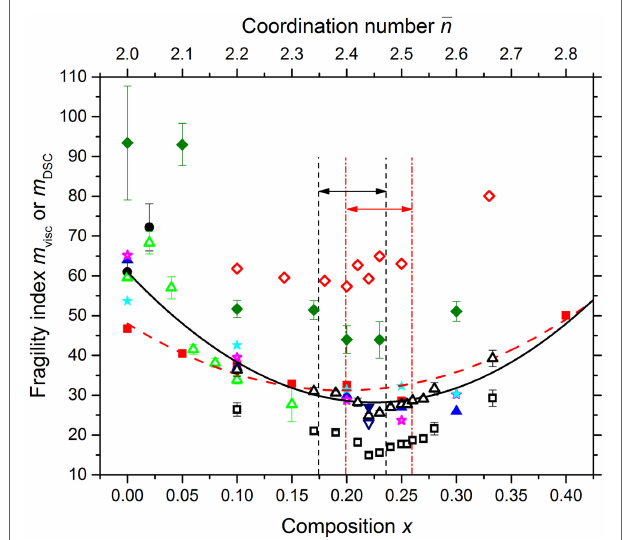
FIGURE 12 | The dependence of the fragility index m visc or m DSC for the Ge x Se 1 (cid:0) x system on the composition x and mean coordination number ¯ n = 2 ( 1 + x ) . The data points are from the viscosity measurements of Senapati and Varshneya (1996) [solid (red) squares (cid:4) ], Gueguen et al. (2011) [solid (blue) triangles N ] and Svoboda and Málek (2015) [solid (black) circles • ], or from fits to viscosity data using the MYEGA model with the logarithm of the high-temperature viscosity treated as either a fitting parameter [solid (magenta) stars ⋆ ] or a fixed parameter set at log 10 [ (cid:17) 1 (Pas)] = − 2.93 [solid (cyan) stars ⋆ ]. Least-squares parabolic fits are shown for (i) all of these viscosity derived data points [solid (black) curve] and (ii) solely the m visc values of Senapati and Varshneya (1996) [broken (red) curve]. The m visc values estimated from the molecular dynamics work of Yildirim et al. (2016b) are ⋄ given by the open (red) diamonds . Also shown are the m DSC values from Gunasekera et al. (2013) as measured [open (black) squares (cid:3) ] or after shifting by 10 units [open (black) triangles △ ]; Svoboda and Málek (2015) [open (green) triangles △ ]; Li et al. (2017) for samples prepared at x = 0.22 using short and long sample reaction times of 34h [open (blue) downward triangle ▽ ] versus 192h [solid (blue) downward triangle H ]; and Zhao et al. (2013) [solid (green) diamonds (cid:7) ]. The pairs of vertical dashed (black) or chained (red) lines, and associated horizonal arrows, mark compositions for which ∆ H nr ≃ 0 as found in the present work or in the work of Boolchand et al. (2001a), respectively.